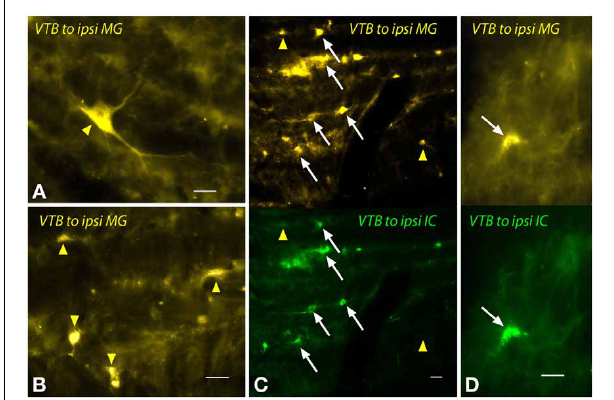
FIGURE 7 | Photomicrographs showing labeled cells in the ventral nucleus of the trapezoid body (VTB) after injections into the medial geniculate nucleus (MG) and the inferior colliculus (IC). (A,B) Labeled cells (yellow arrowheads) after a large injection of FluoroGold into the ipsilateral MG (GP597). (C,D) Single- and double-labeled cells in the left VTB after injections of FluoroGold into the left MG and green beads into the left IC (GP597). For each panel, the upper half shows cells labeled with FluoroGold and the lower half shows the same area visualized to see green beads. White arrows indicate cells labeled with both tracers. Other cells are labeled with only FluoroGold (yellow arrowheads) or green beads (unmarked). Scale bar = 20 µ m. All panels: transverse sections; dorsal is up; lateral is to the left. Abbreviations: contra, contralateral; ipsi, ipsilateral.